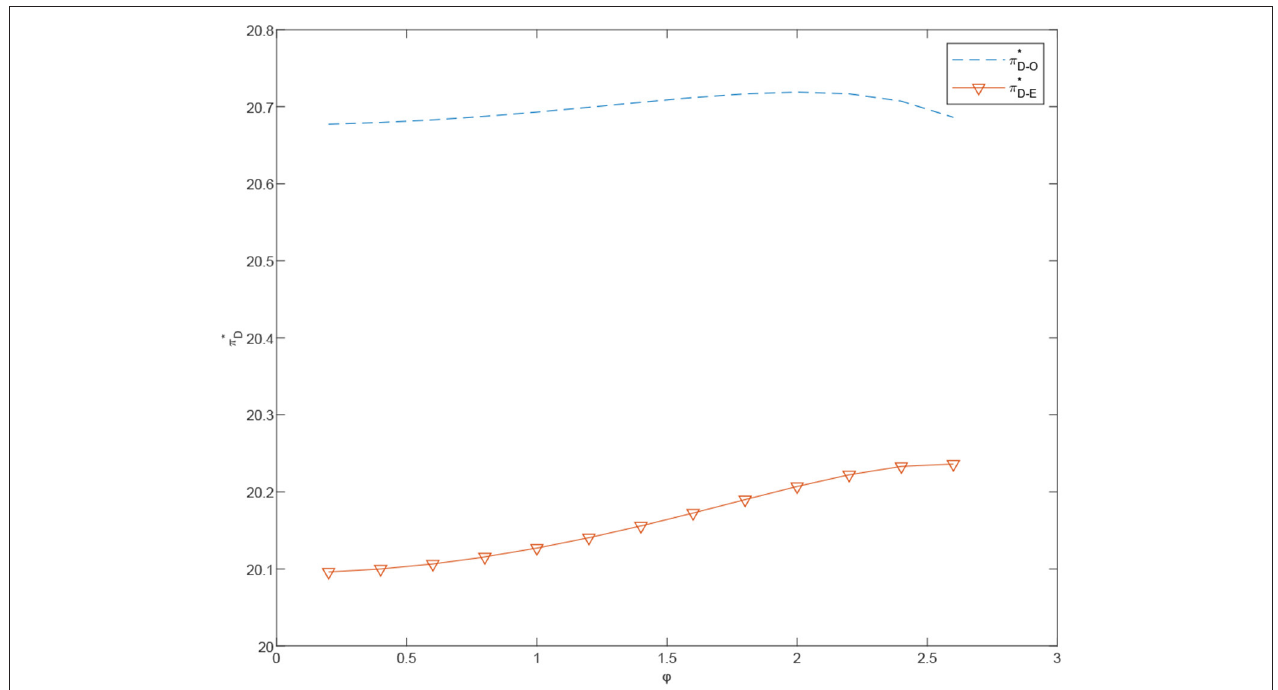
FIGURE 9 | The effects of ϕ on the prices under the decentralized scenario, π ∗ D − E and π ∗ D − O .